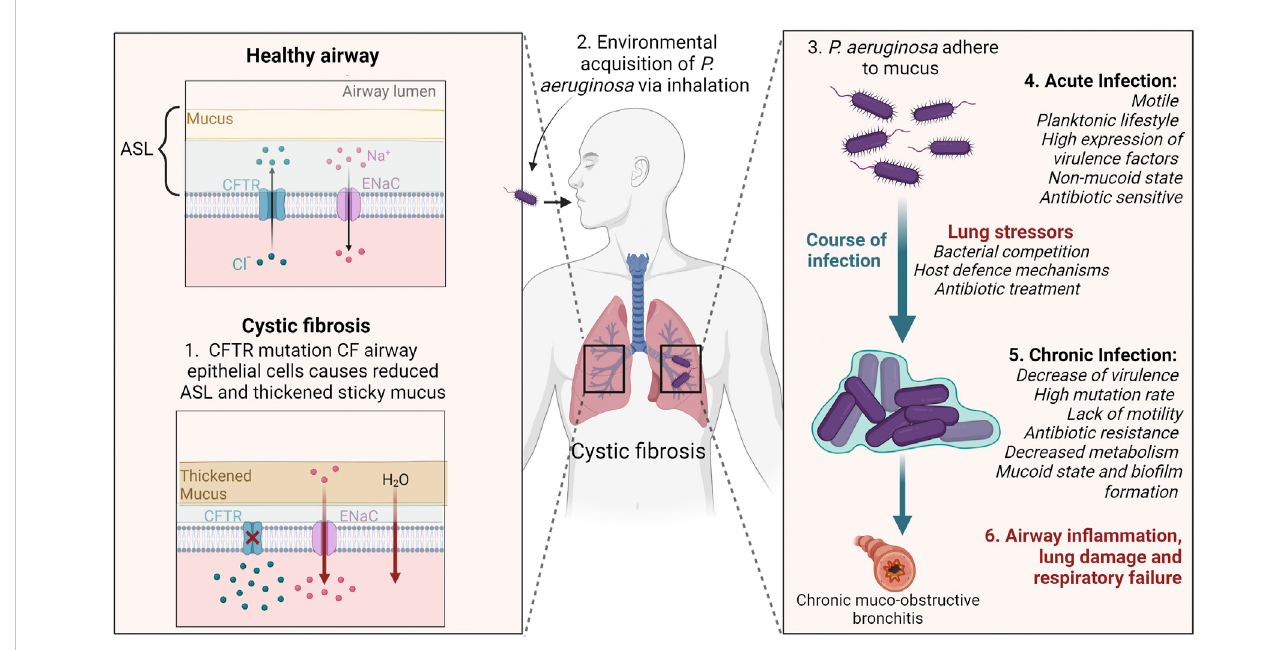
FIGURE 1 Schematic illustrating Pseudomonas aeruginosa infection and adaptation to cystic fi brosis (CF) lungs. CFTR mutations reduce chloride transport in the airways causing hyperabsorption of sodium, and water to be absorbed into the tissue. In turn, the ASL becomes dehydrated, thickened sticky mucus accumulates and mucocillary clearance is impaired. Environmentally acquired P. aeruginosa adhere to the mucus and cannot be cleared. During early infection stages P. aeruginosa have fl agella and pili present for motility. The stressful conditions of the CF lung creates selective pressures that cause P. aeruginosa to accumulate gene mutations enabling it to adapt to the lung environment. In the chronic infection stage, P. aeruginosa develops characteristics including loss of the fl agella and pili, overproduction of alginate bio fi lm, and resistance to antibiotics. Chronic lung infections result in airway in fl ammation, lung tissue damage and eventually respiratory failure. CFTR; cystic fi brosis transmembrane conductance regulator, ENaC; epithelial sodium channel, ASL; airway surface liquid. Created with